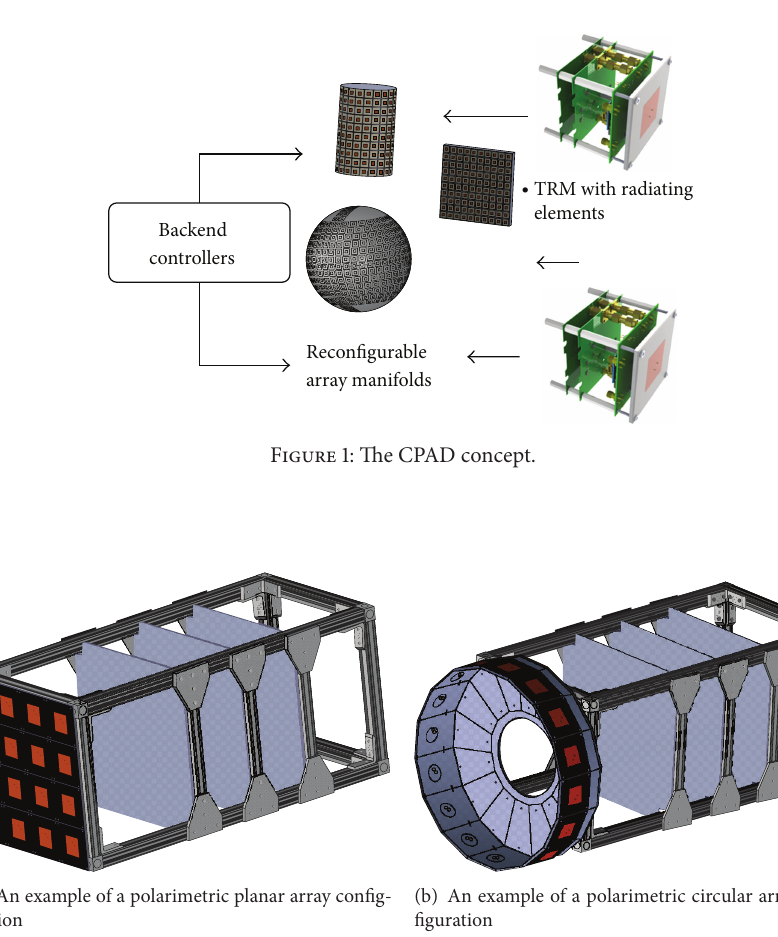
Figure 2: 3D model of example CPAD